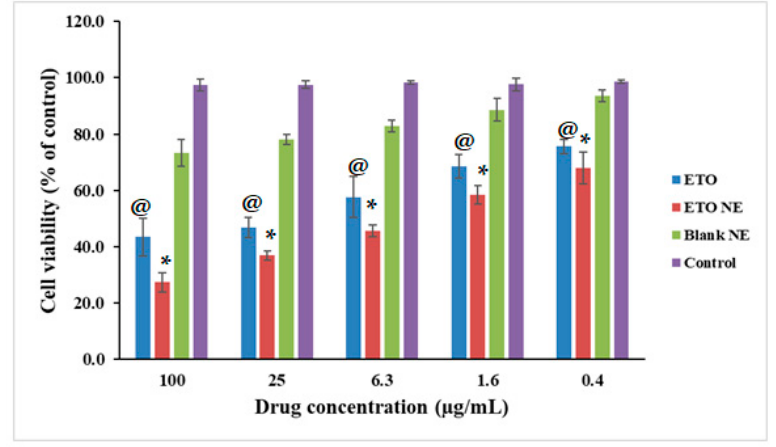
Figure 5. Cell viability assays of ETO NE, free ETO and blank NE group were presented. Control group is 100% cell viability. Values are expressed as mean ± SD ( n = 3). * denotes significant difference between ETO NE ( p < 0.05) vs. free ETO [except at 0.4 µg/mL ( p > 0.05)] and blank NE. @ denotes significant difference between free ETO vs. blank NE ( p < 0.05).